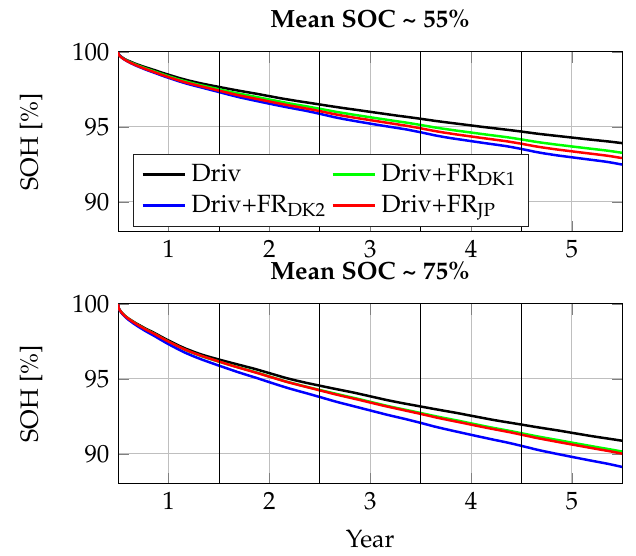
Figure 9. SOH comparison of the driv and driv + FR scenarios over five years in DK1, DK2 and JP: subplot 1 with average SOC 55% and subplot 2 with average SOC